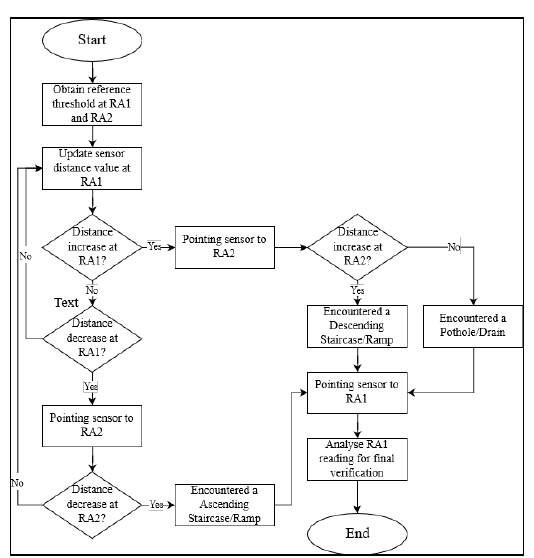
Figure 3. Ground Plane Detection Block Diagram.